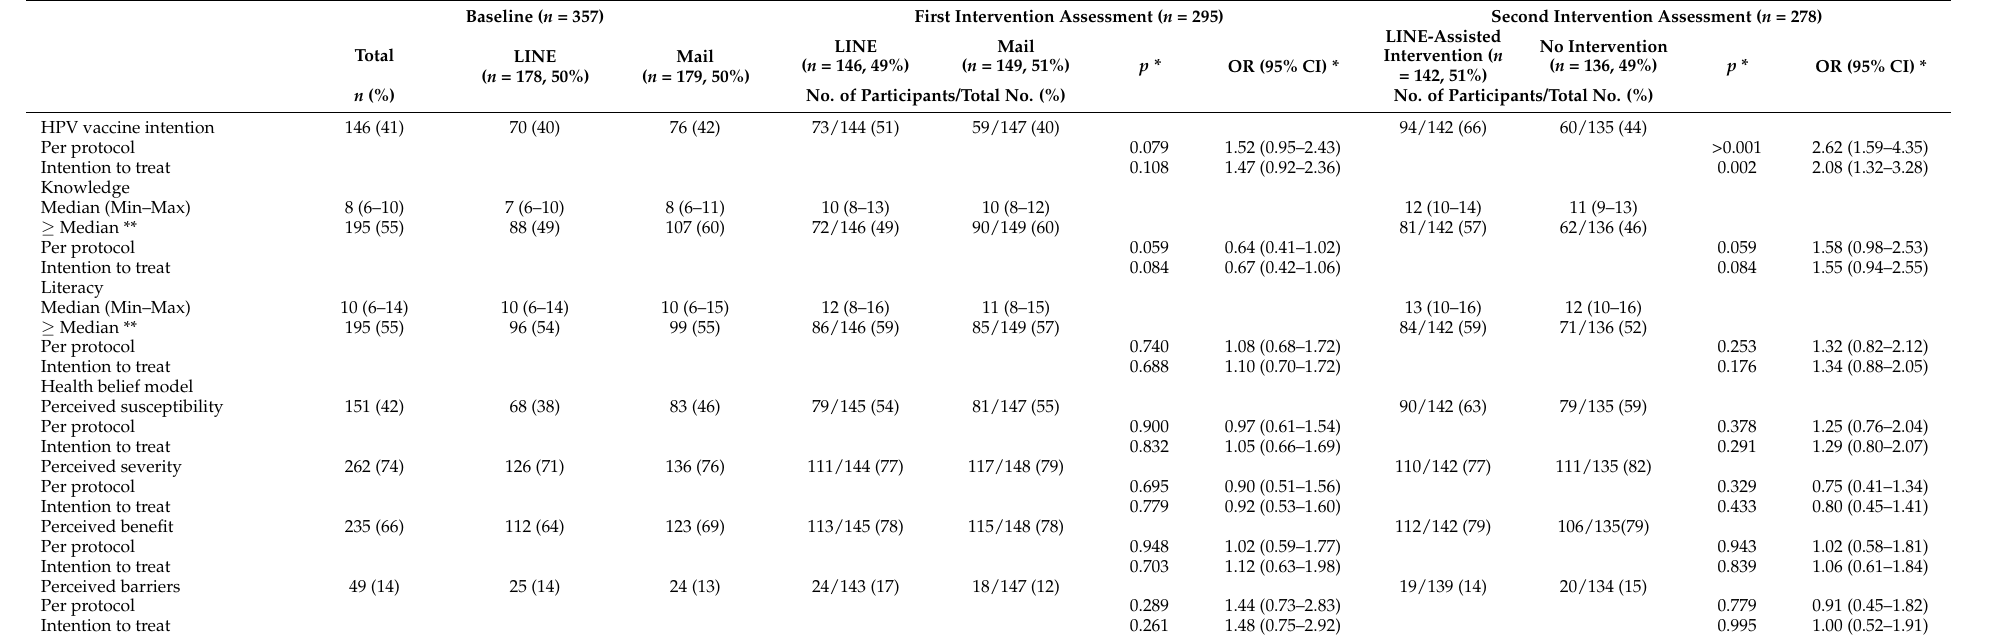
Table 2. Comparison of HPV vaccine intention, knowledge, literacy, and health belief model at the first and second